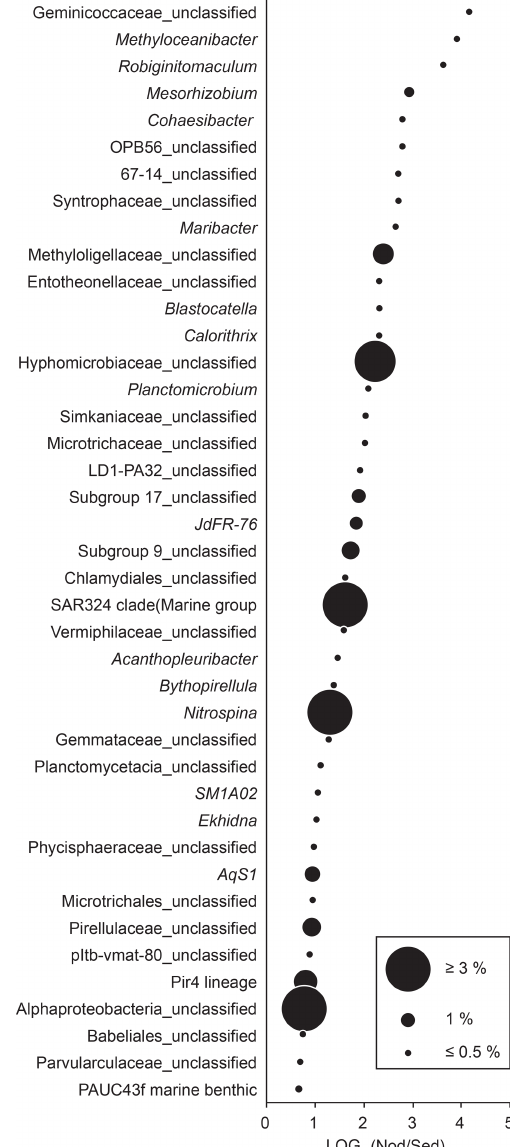
Figure 4. Taxa highly abundant in nodules (ALDEx2: glm-adjusted p of < 0 . 01; KW-adjusted p of < 0 . 05). The base 2 logarithm of the ratios between the sequence number of nodules (Nod) and sedi- ments (Sed) centred by geometric mean as well as the average con- tribution of total number of sequences (%) retrieved in nodules and in sediments is shown. For details see Table S3.